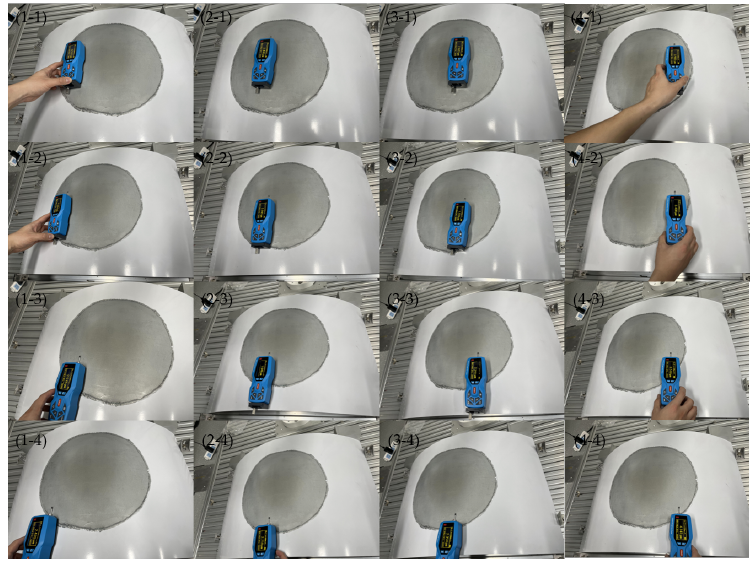
Figure 26. Roughness measurement before grinding. The roughness data for each point before and after grinding are shown in Figure 28. We measured 16 groups of roughness data on the surface of the workpiece after grinding, where 15 groups of roughness were below 0.8 microns and one group was 0.87 microns, meeting the requirements of aerospace grinding technology. Prior to grinding, the roughness of each point was larger with a wider range of variation, and the average value was 2.943. After grinding, the roughness of each point was significantly reduced, and the differences between the roughness values for each point were small, with an average value of 0.57. The average roughness value decreased by 80.63%, indicating the effectiveness of the spiral grinding method for grinding large aluminum alloy